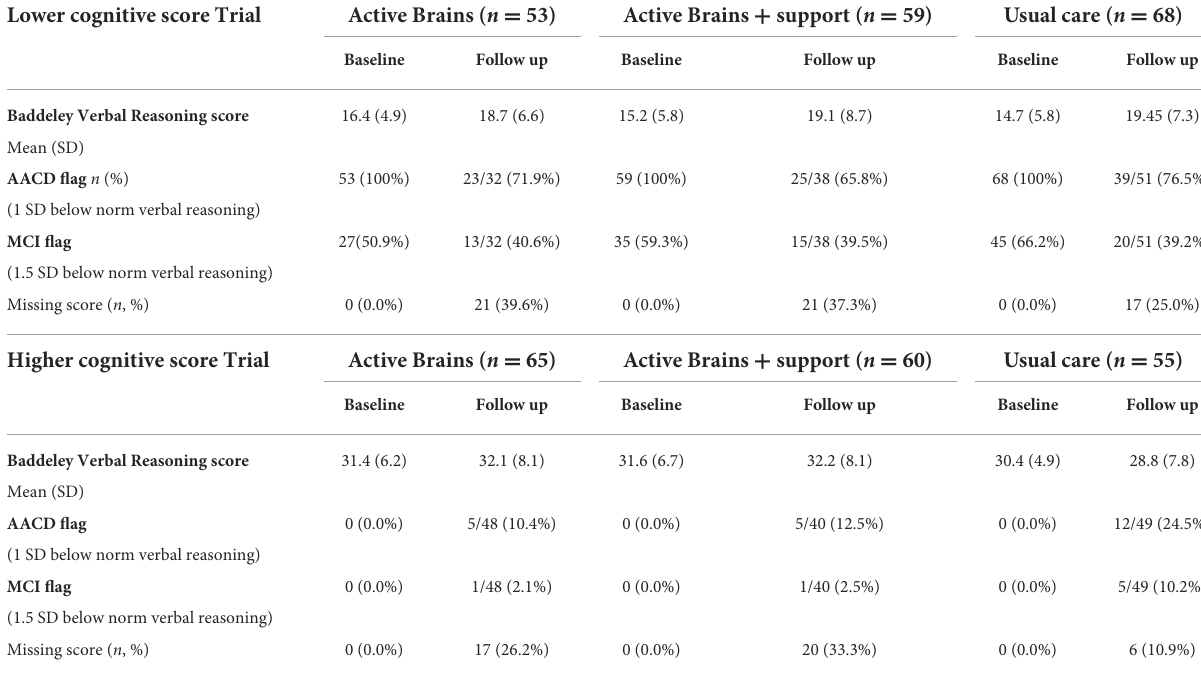
TABLE 5 Baddeley Verbal Reasoning task scores and number meeting AACD/MCI